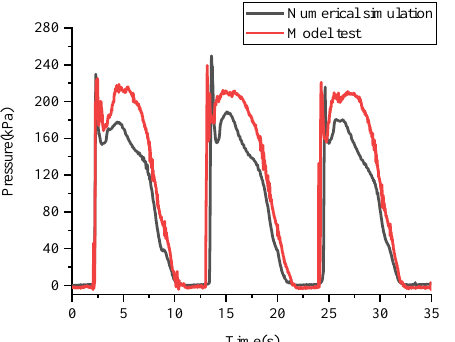
Figure 11. Comparison of K-point slamming pressure under the wave condition with H = 20 m, T = 11 s.